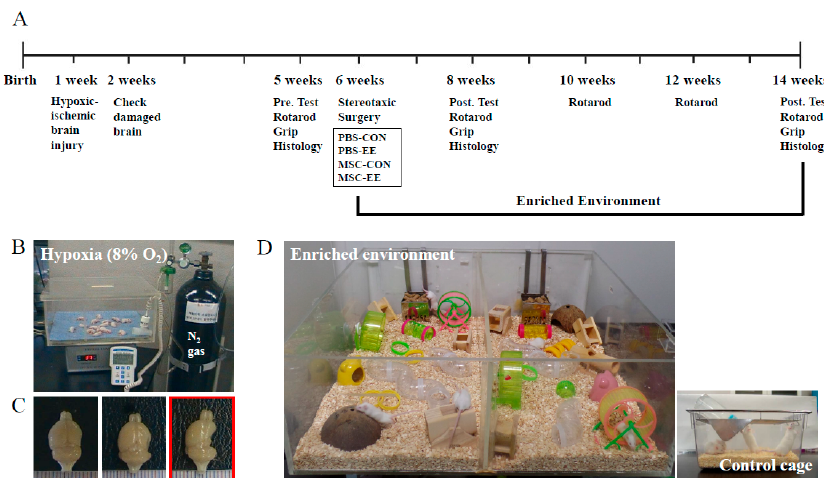
Figure 1. Experimental designs: ( A ) Schematic timeline of the experimental procedures; ( B ) mice were monitored in hypoxic conditions (8% O 2 ) controlled with N 2 gas for 90 min after unilateral carotid artery ligation; ( C ) in the left and middle panels, the damaged brain showed an ipsilateral lesion in the posterolateral hemisphere, while the right panel in the red box shows that severely injured mice were excluded from this study; and ( D ) an enriched environment, including tunnels, shelters, toys, running wheels for voluntary exercise, and social interaction and standard cage at the right bottom.